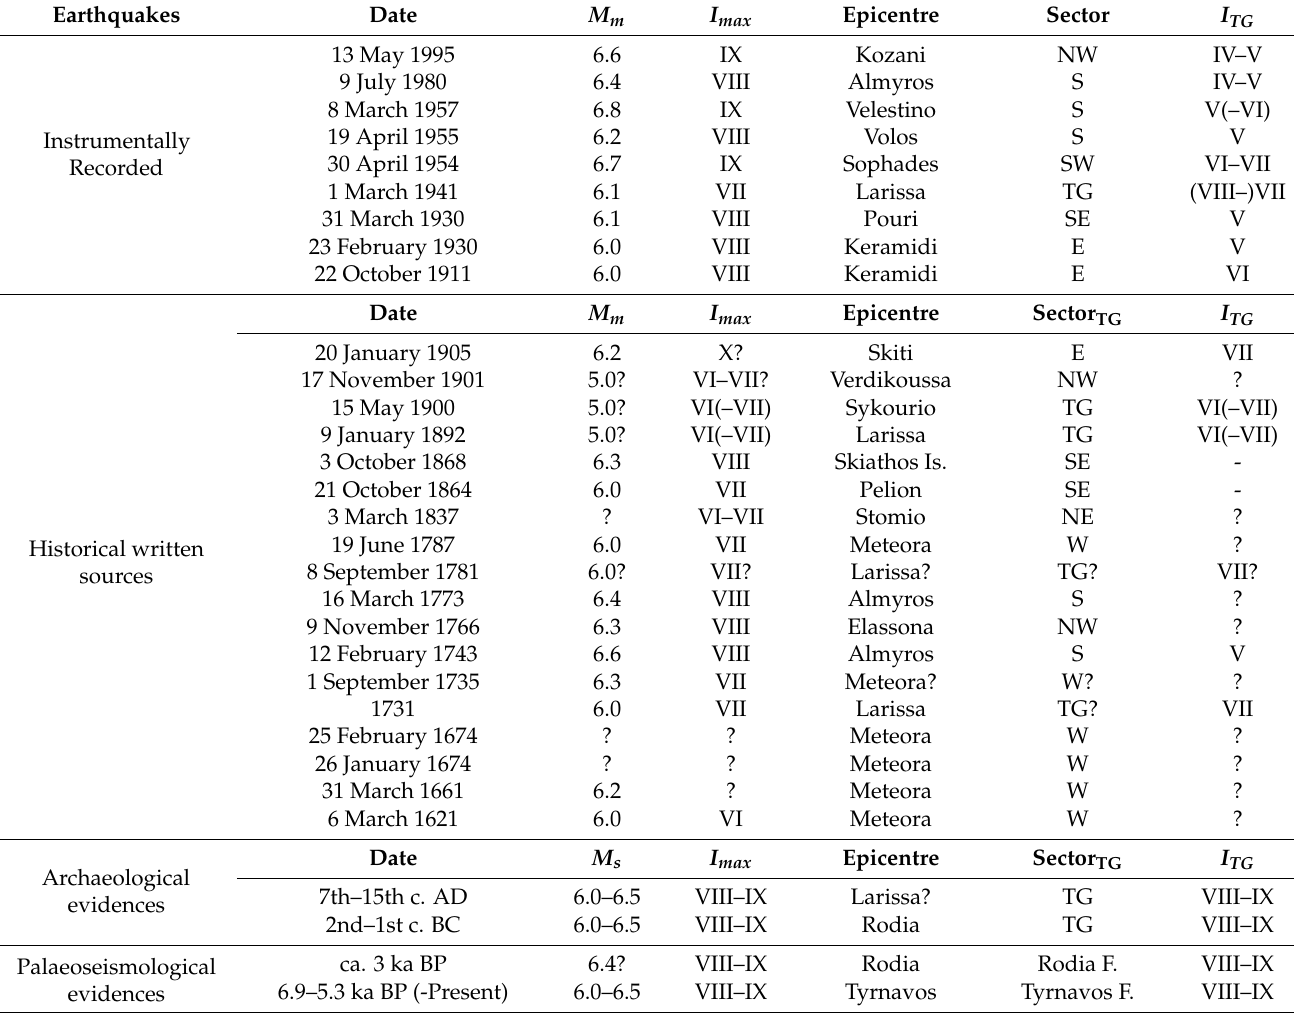
Table 1. Various sources of historic seismicity of Thessaly based on [21] and references therein. I max = maximum macroseismic intensity; I TG = maximum macroseismic intensity in Tyrnavos Graben; TG = Tyrnavos Graben, sector = location of epicentral area with respect to TG; I TG = maximum intensity within TG (observed in group A and inferred in B–D); M m = macroseismic magnitude.